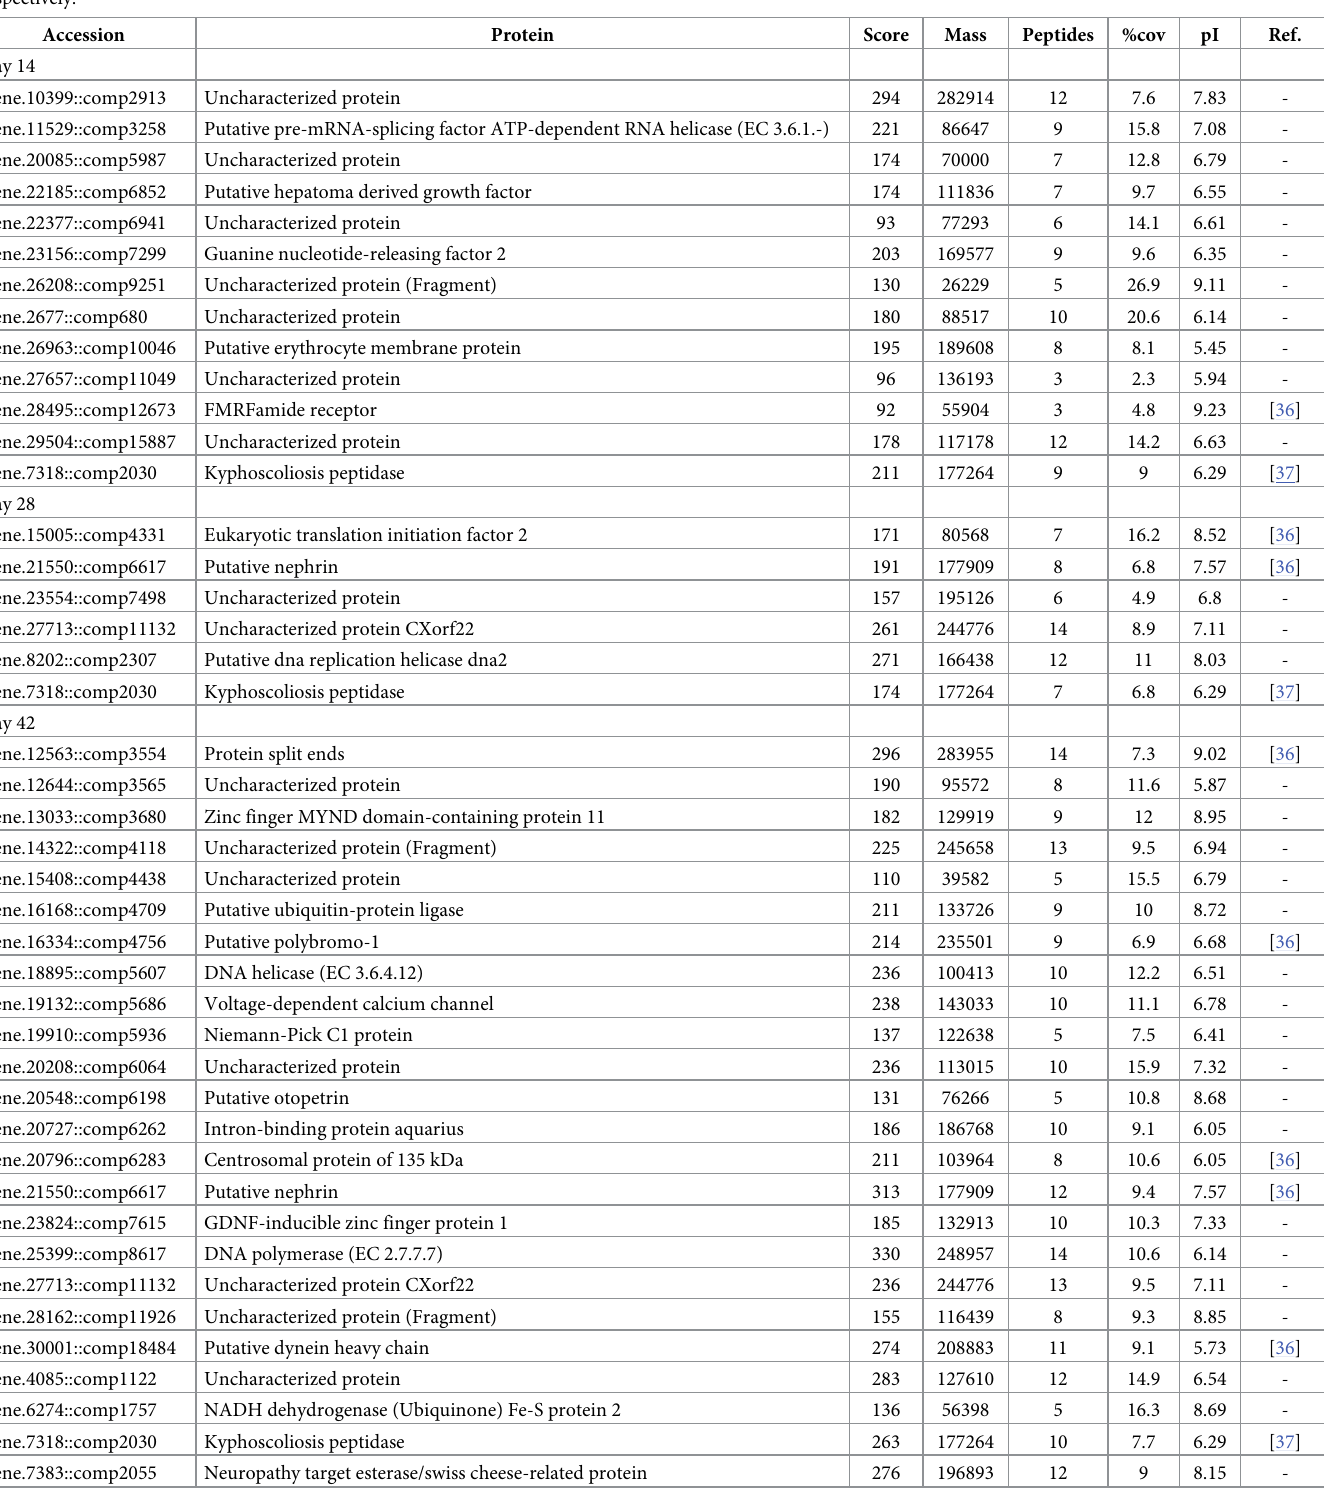
Table 2. Circulating proteins of S . mekongi identified in infected mouse sera at 14-, 28-, 42-, and 56-days post-infection. LC-MS/MS and the in-house database were used, with S . mekongi set as the taxonomy filter. The SignalP score ( > 0.9) and Secretome score ( > 0.6) were used to define classical and non-classical protein secretion,